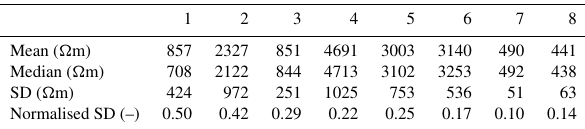
Figure 7. Subdivision of the ERT image in eight distinct regions based on their average resistivity values and arbitrary thresholds. Table 1 presents characteristics of the temporal evolution associated with each region. Table 1. Statistics of the temporal evolution of the median of the absolute resistivity values for the eight regions defined in Fig. 7. For the values of each region, the table shows the temporal mean, median, standard deviation (SD) and SD normalised to the temporal mean resistivity. GD data sets are used for superficial regions (1, 2, 3 in Fig. 7) given the better resolution of that protocol at shallow depths. Resistivity values of the deeper regions (4, 5, 6, 7, 8) come from the DD surveys, because of the greater imaging resolution at